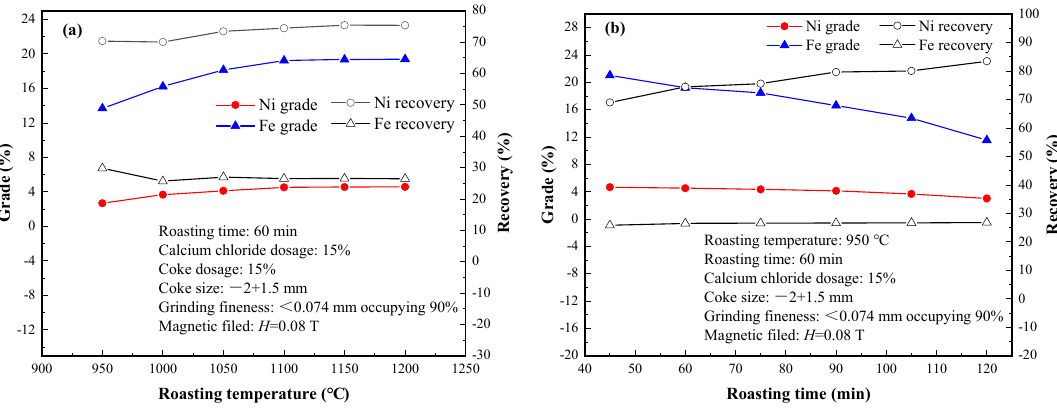
Figure 4. E ff ect of segregation roasting temperature ( a ) and segregation roasting time ( b ) on nickel extraction.